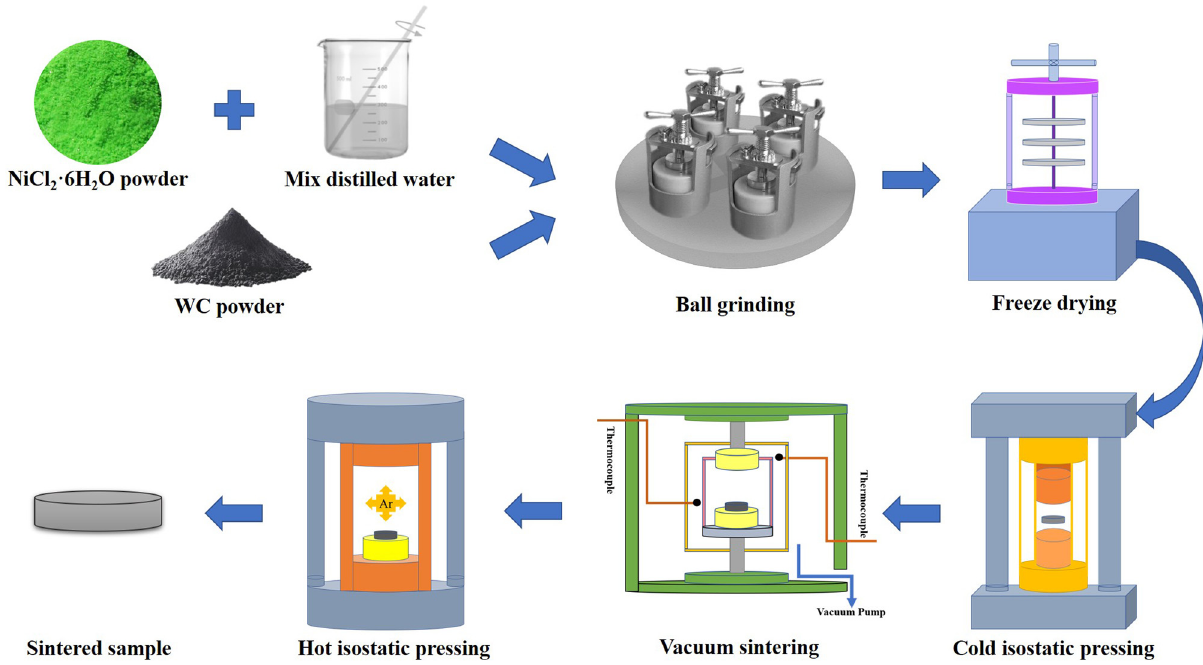
Figure 1: Flow chart of the experimental specimen preparation.